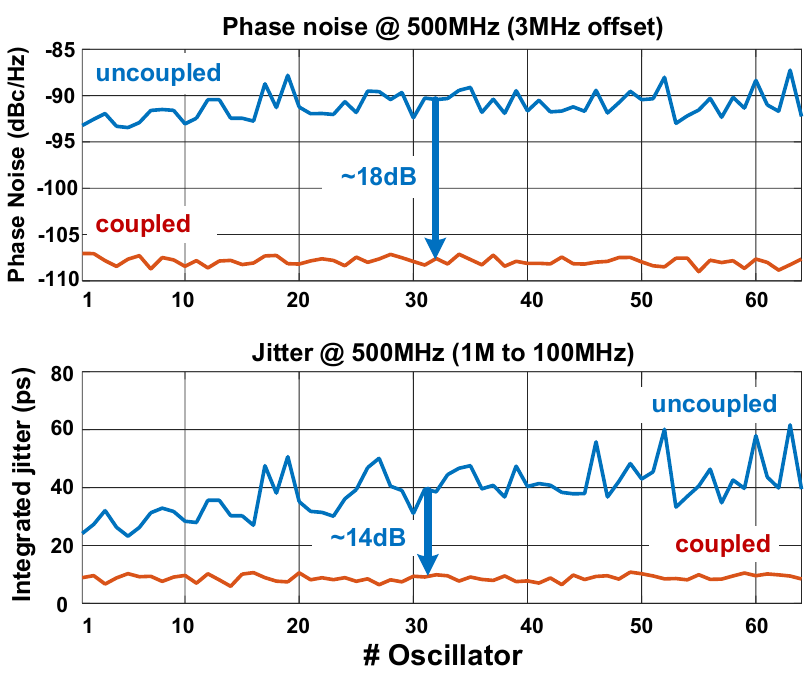
Figure 20. Phase noise and integrated root mean square (RMS) jitter comparison for uncoupled and coupled modes, for all 64 ROs at 500MHz center